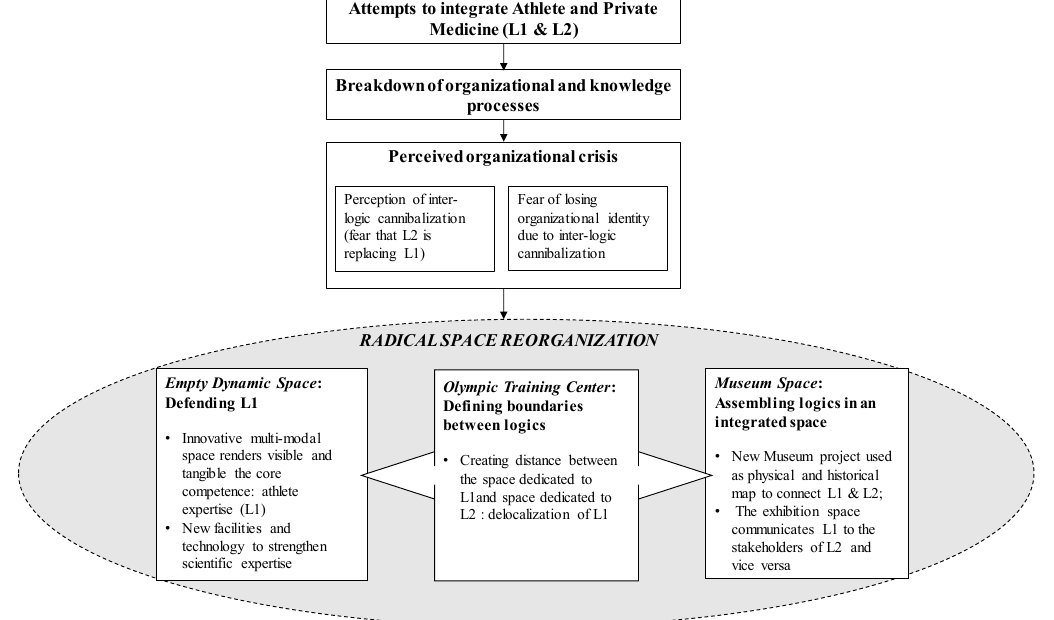
Fig. 3. Second ambidexterity experiment: radical space reorganization to reinforce logic 1 and avoid inter-logic cannibalization